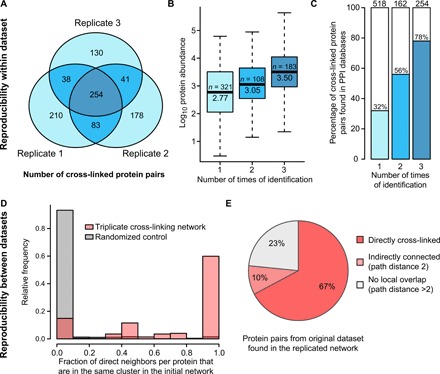
Evaluation of the XL-MS approach on three biologically independent replicates for hippocampal synaptosomes.(A) Venn diagram showing the number of identified cross-linked protein pairs (from interprotein cross-links) in different replicates (dataset 2). (B) Boxplot showing the distribution of protein abundances for cross-linked protein pairs identified in one, two, and all three replicates. The number of proteins and median abundance are indicated in each box. Protein abundance data were obtained from (12). (C) Percentage of cross-linked protein pairs present in any PPI databases (i.e., STRING, InWEB, and BioGRID) identified in one, two, and all three replicates. The total number of cross-linked protein pairs identified is indicated above each bar. (D) Distribution of the fraction of direct neighbors (cross-linked proteins pairs) from the triplicate dataset that are in the same cluster in the initial network (Fig. 3A, labeled in red) and a randomly rewired network (100 iterations, labeled in gray). (E) Pie chart showing the percentage of protein pairs from the initial hippocampal synaptosome dataset identified in the triplicate network. Only proteins containing interprotein cross-links in both datasets were considered.